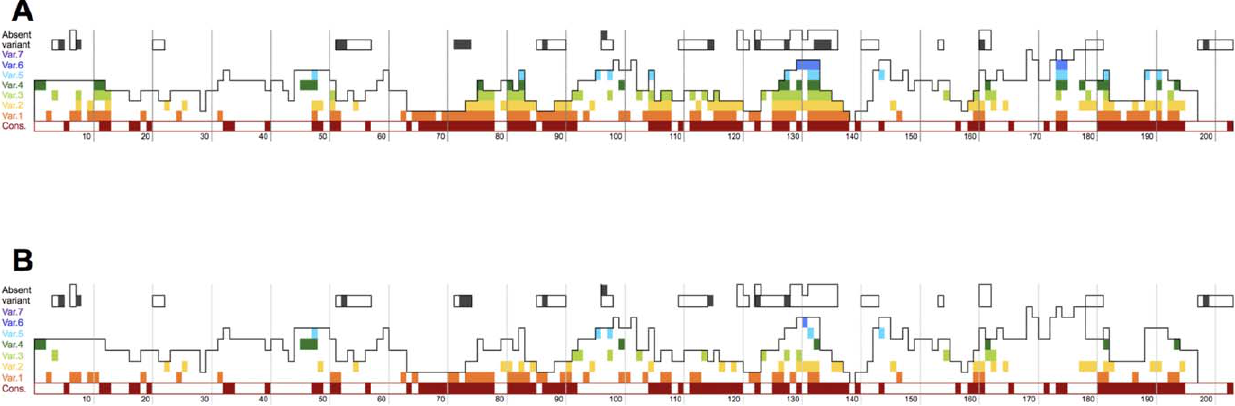
Figure 2. Distribution of reactive consensus and variant 10-mer peptides. Colored blocks correspond to the 10-mers that were recognized, while the 10-mers that were tested are outlined in black. Recognition of peptides is figured using a gradient of colors: consensus peptides are figured in burgundy and variant peptides follow a gradient from the most conserved (in orange) to the most rare (in purple), while peptides not found in a database of 514 sequences are in black. Each block represents the start position of the 10-mers based on their HXB2 coordinates. Panel A shows all the peptides recognized, panel B represents for each individual only the most frequent peptide recognized at each position (i.e., if an individual recognized the consensus peptide and variants 1 and 4, only the recognition through the consensus is figured).